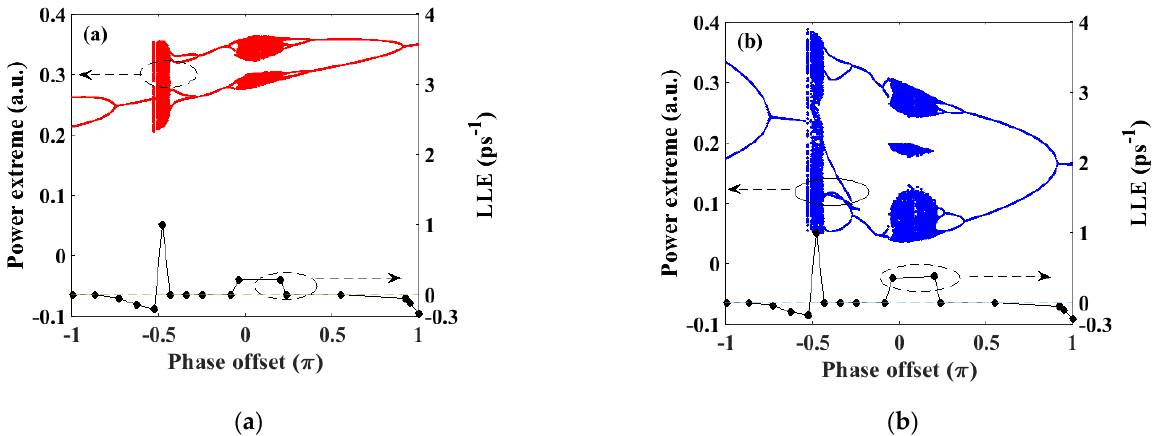
Figure 5. Bifurcation diagrams of the power extreme; LLE as a function of phase offset of the GS lasing ( a ) and ES lasing ( b ) in a TSQDL under I = 120 mA and k = 0.1.